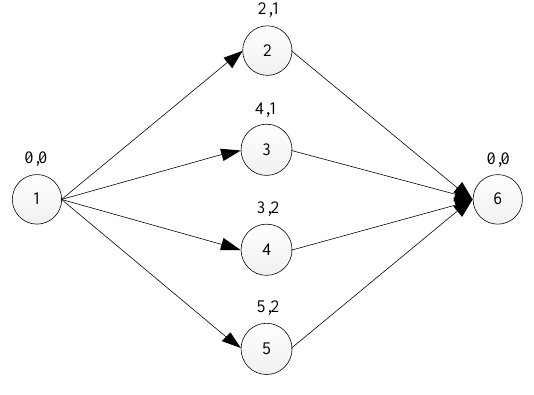
Fig.1. Sample project network